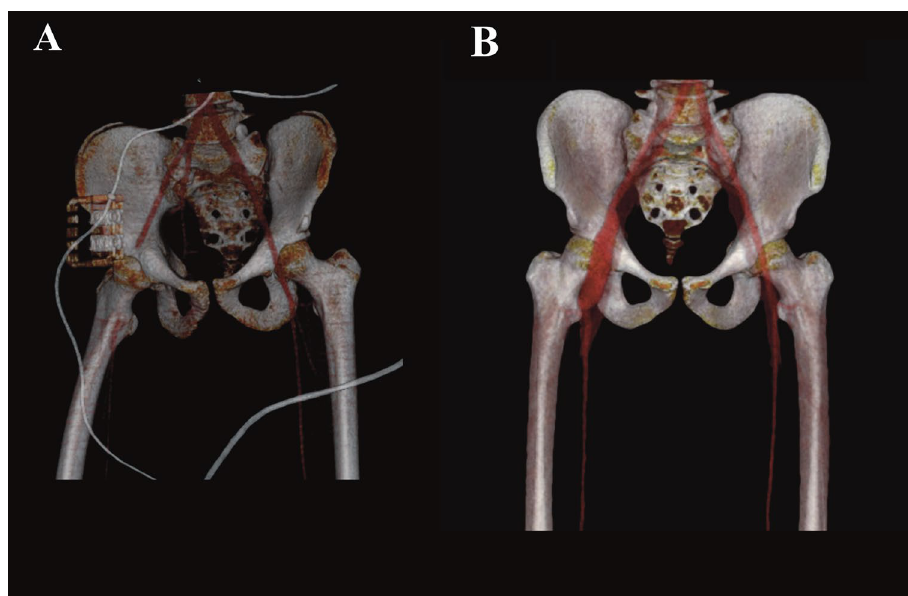
Figure 2. Pre- and postoperative 3D reconstruction of a patient after a bike accident and dissection of the right femoral artery. ( A ) Preoperative imaging of the patient. ( B ) Postoperative imaging 3 years after a GSV ilio- femoral bypass (*graft dilation up to 22